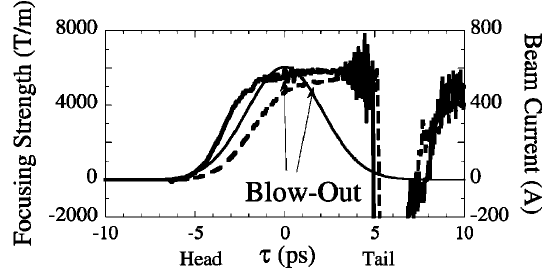
FIG. 1. Transverse focusing strength of the wake excited by an electron bunch (thin line) at a high bunch density (solid line) and a low bunch density (dashed line) in a plasma with a (cid:7) 2 (cid:3) 10 14 cm (cid:4) 3 , as obtained constant plasma density, n p from particle-in-cell computer